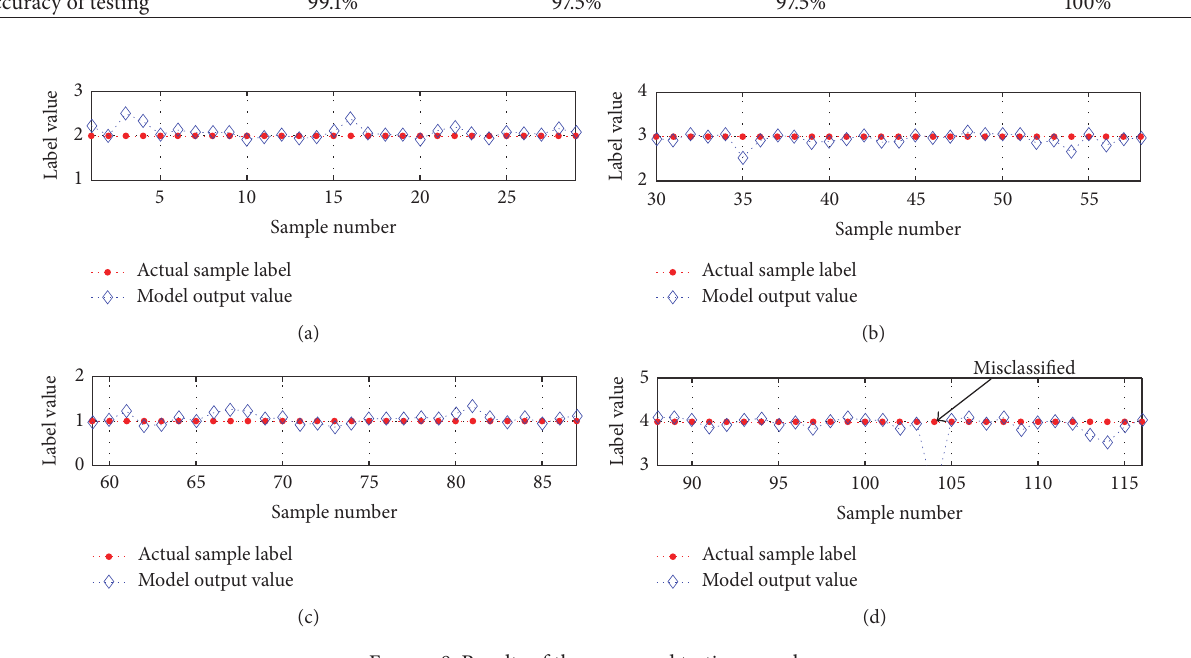
Figure 8: Results of the processed testing samples.